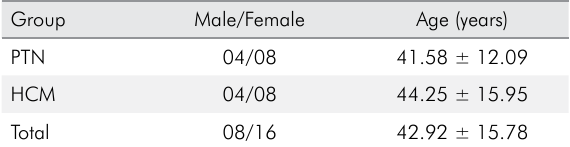
Table 1. Demographic data of the study.